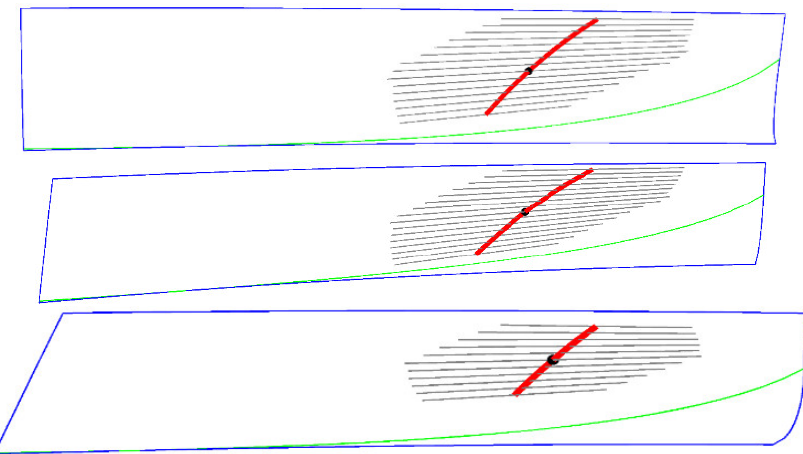
◦ ; middle: γ ◦ ; below: m = 80 m = 90